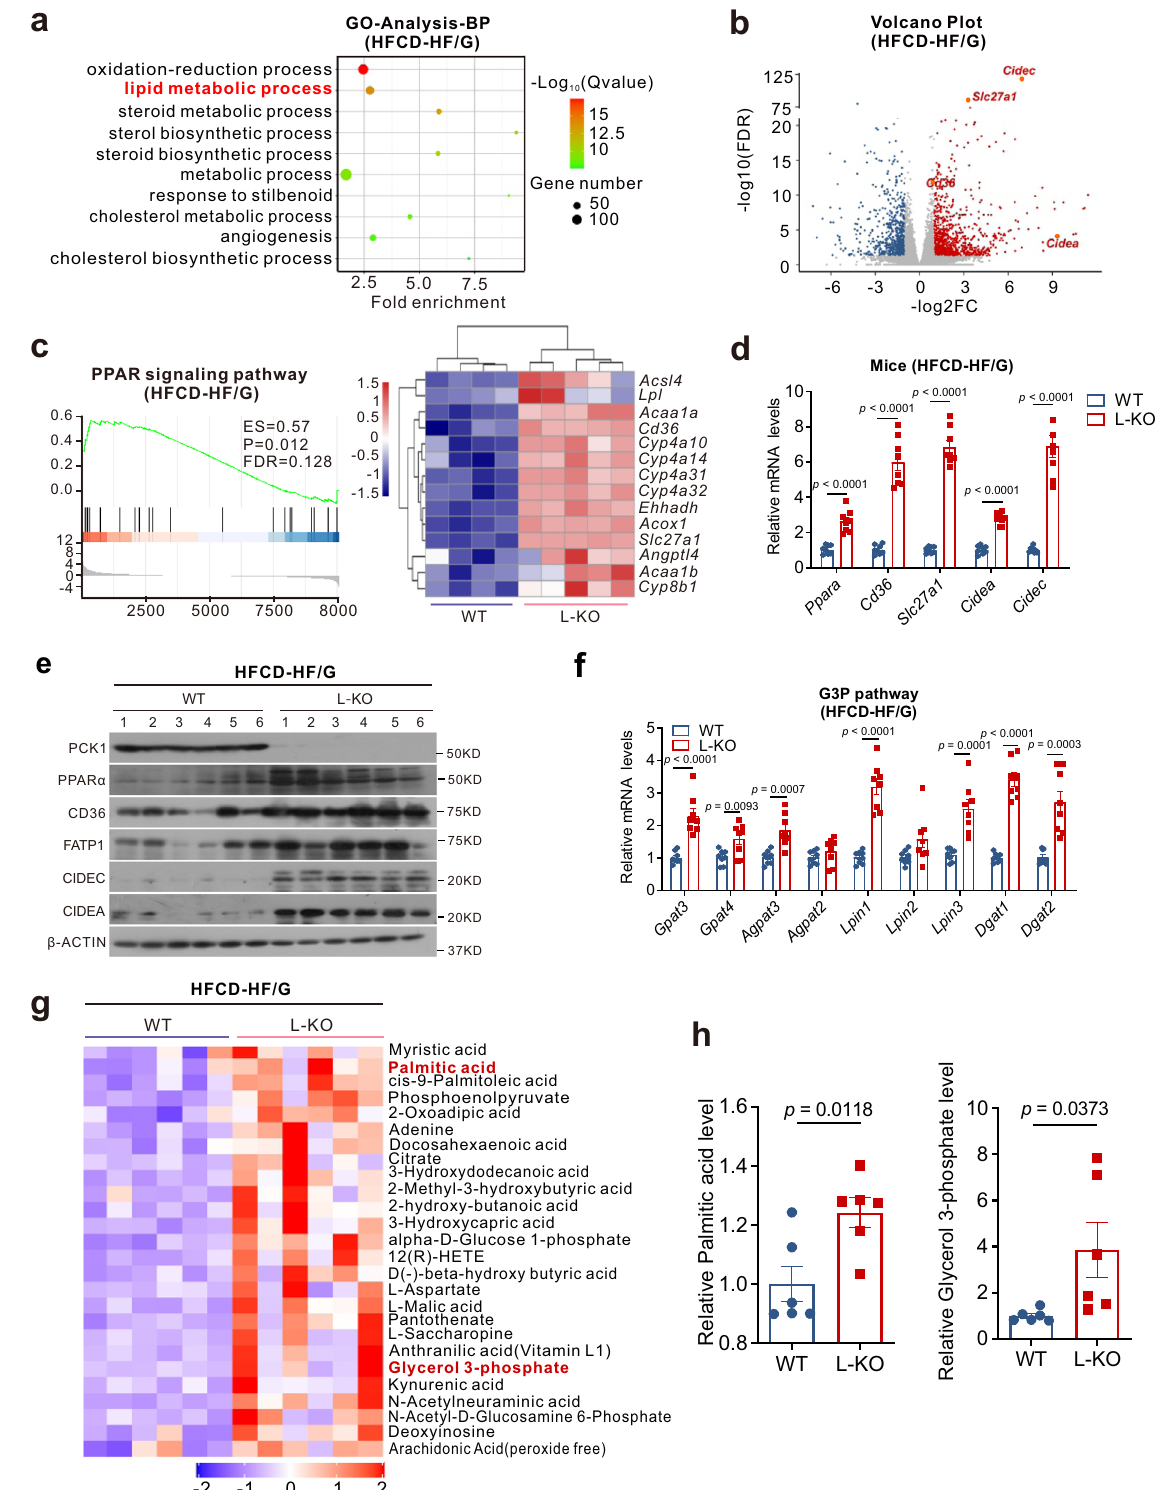
Fig. 4 | Loss of PCK1 promotes lipid accumulation according to transcriptome and metabolome analyses. RNA sequencing was performed on the livers of WT ( n =4) and L-KO (n=5) mice fed the HFCD-HF/G. a Gene Ontology analysis of all signi fi cantly changed genes in top 10 biological processes. b Volcano plot repre- sentation of signi fi cantly up- and downregulated genes. c Gene Set Enrichment Analysis plot (left) of enrichment in “ PPAR signaling pathway ” signature; heatmap (right)ofsigni fi cantlyupregulatedPPARtargetgenes. d , e QuantitativePCR( d )and